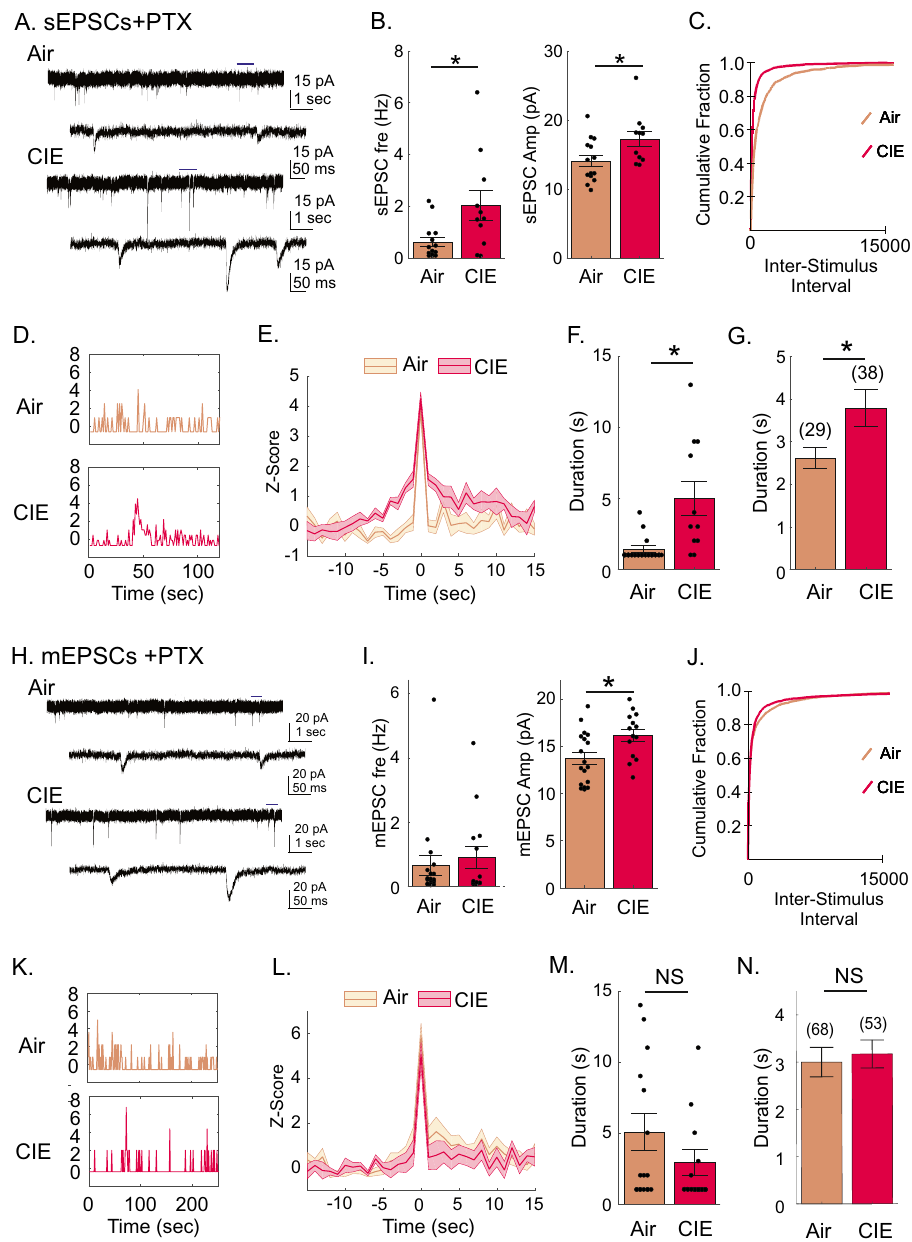
Figure 6. Action potential-dependent, but not action potential-independent, intrinsic network excitability is increased in CIE-treated rats. ( A ) Representative sEPSC traces recorded from vSub neurons of Air (top two traces) and CIE-treated (lower two traces) rats. ( B ) CIE rats have an increased sEPSC frequency (left graph), as well as amplitude, in the presences of PTX (right graph). ( C ) Cumulative probability plots of sEPSC inter-stimulus intervals in the population of neurons from Air and CIE-treated rats. ( D ) Representative example of an individual vSub neuron’s second-by-second z-scores (normalized sEPSC frequency) in Air (top panel) and CIE (bottom panel) rats. ( E ) Duration of z-scores aligned to the peak of z-score in Air (beige lines and shaded area, peak n = 14) and CIE-treated (red lines and shaded area, peak n = 11) rats. Lines represent mean z-score while shaded area represents SEM. ( F ) CIE-treated rats have an increased duration of peak z-scores and ( G ) duration of all instances when z-scores were above a z-score of 1. ( H ) Representative mEPSC traces recorded from vSub neurons of Air (top two traces) and CIE-treated (lower two traces) rats. ( I ) CIE rats do not show changes in mEPSC frequency (left graph), but do show an increased amplitude, in the presences of PTX (right graph). ( J ) Cumulative probability plots of mEPSC inter- stimulus intervals in the population of neurons from Air and CIE-treated rats. ( K ) Representative example of an individual vSub neuron’s second-by-second z-scores (normalized mEPSC frequency) in Air (top panel) and CIE (bottom panel) rats. ( L ) Duration of z-scores aligned to the peak of z-scores in Air (beige lines and shaded area, peak n = 14) and CIE-treated (red lines and shaded area, peak n = 12) rats. Lines represent mean z-score while shaded area represents SEM. ( M ) Air and CIE-treated rats show equivalent durations of peak z-scores and ( N ) durations of all instances when z-scores were above a z-score of 1. Numbers above bar graphs represent the number of instances when z-scores were above a z-score of 1. *p < 0.05 and errors are reported as ±